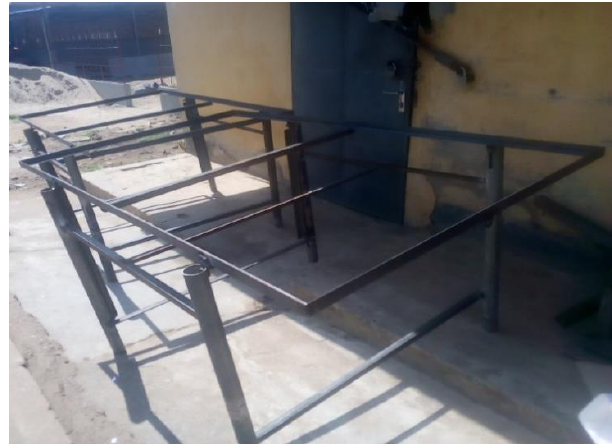
Figure 3: Assembly of metal